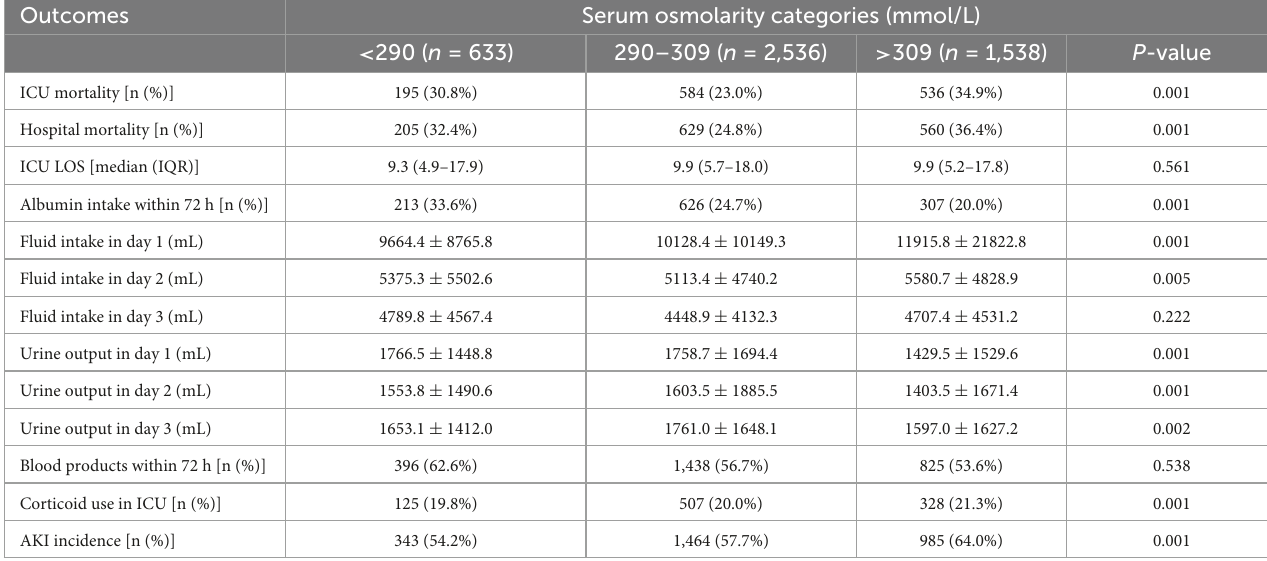
TABLE 2 Clinical outcomes by serum osmolarity categories. Outcomes